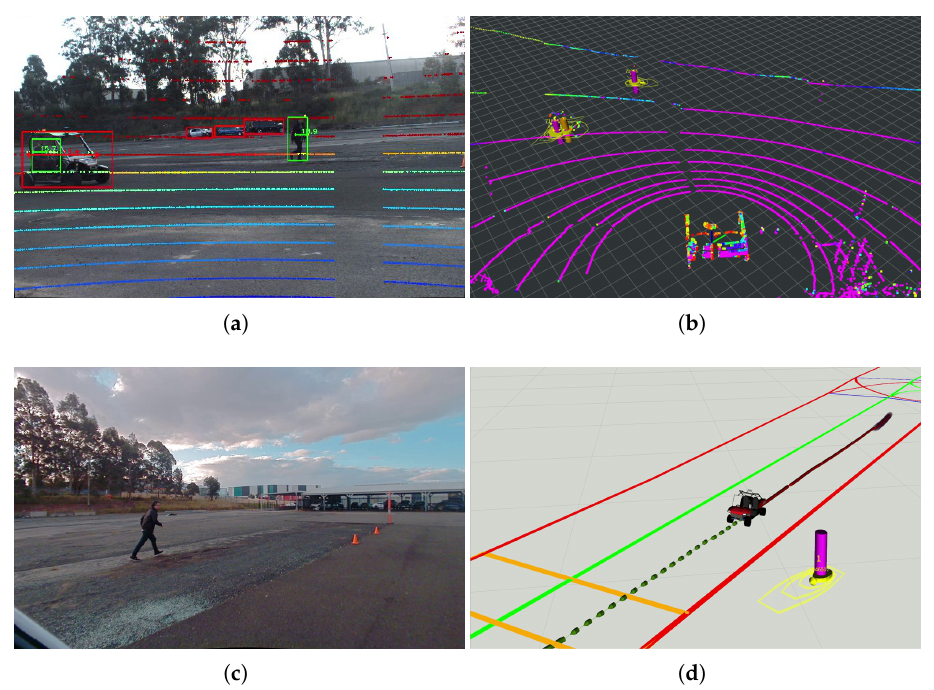
Figure 21. The CAV started tracking a pedestrian running toward a crossing line of a marked pedestrian crossing in a lab environment based on ETSI CPMs from an IRSU. ( a ) shows the image frame from Cam #1 of the IRSU with projected lidar point cloud. ( b , d ) illustrate the tracking of the road users in 3D space in the IRSU and the CAV, respectively, and ( c ) shows the image captured by the front-left camera on the CAV. The pedestrian and the safety driver of the CAV are tracked and denoted by magenta pillars with confidence ellipse and arrows indicating their moving direction, while the vehicle is labelled as an orange pillar in the IRSU’s tracker. Only the running pedestrian was tracked in the GMPHD tracker running within the CAV, as depicted in ( d ), as the CAV itself and its safety driver are identified and removed from tracking based on the location of the received perceived objects after transformed into its local frame. The Lanelet2 map is also visualised in ( d ), where the pedestrian crossing is denoted by an orange rectangle. Furthermore, the odometry trajectory of the CAV is shown as a red line, and its planned path is denoted as a dotted green line in ( d